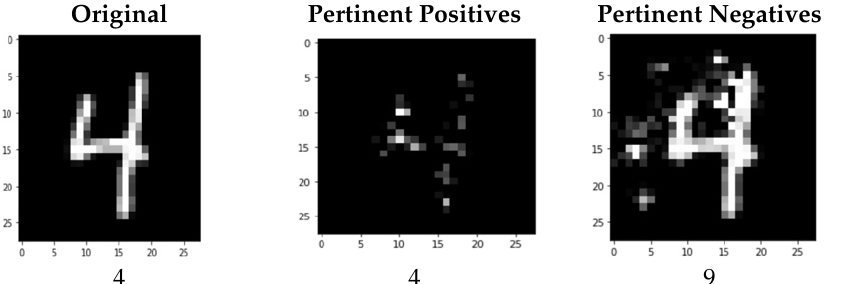
Figure 5. Results of applying CEM to one image of the number four in the MNIST